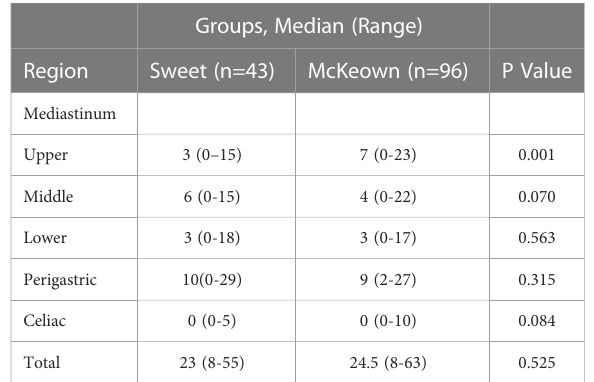
TABLE 5 Number of Lymph Nodes